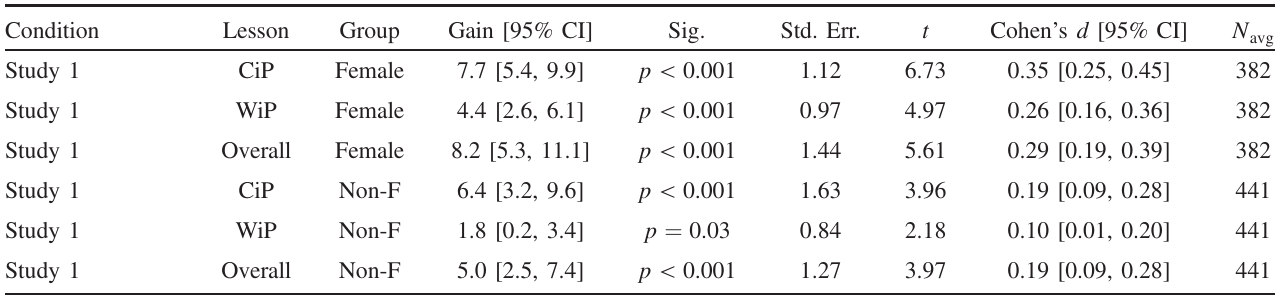
TABLE XII. Summary of paired t tests based on gender group (Female-identified or Nonfemale-identified) for Study 1 and Study 2 (treatment and control groups). Each row represents the paired t test after combining 100 multiply imputed datasets according to Rubin ’ s